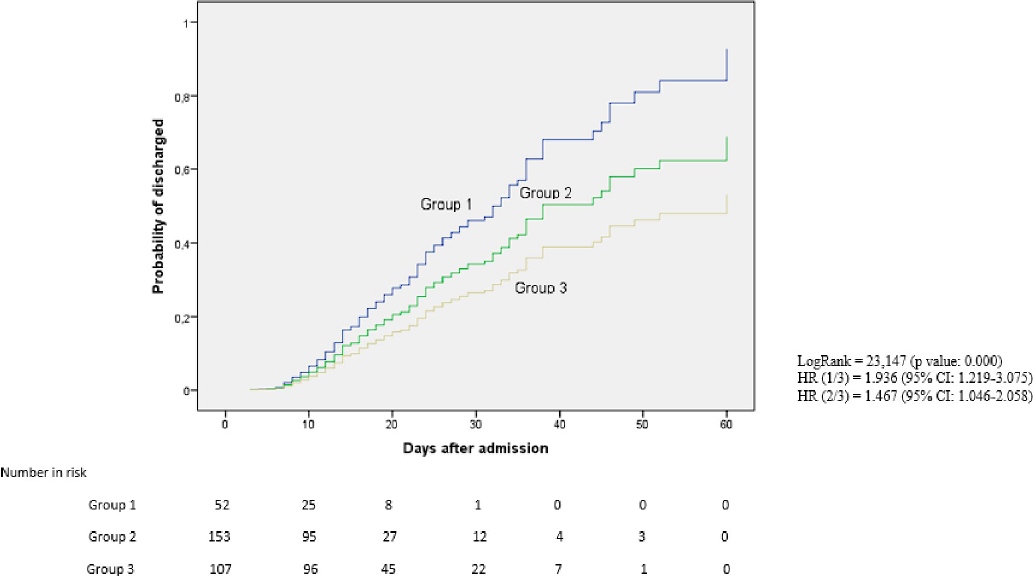
Fig 4. Probability of medical discharge at 60 days in the different treatment groups.